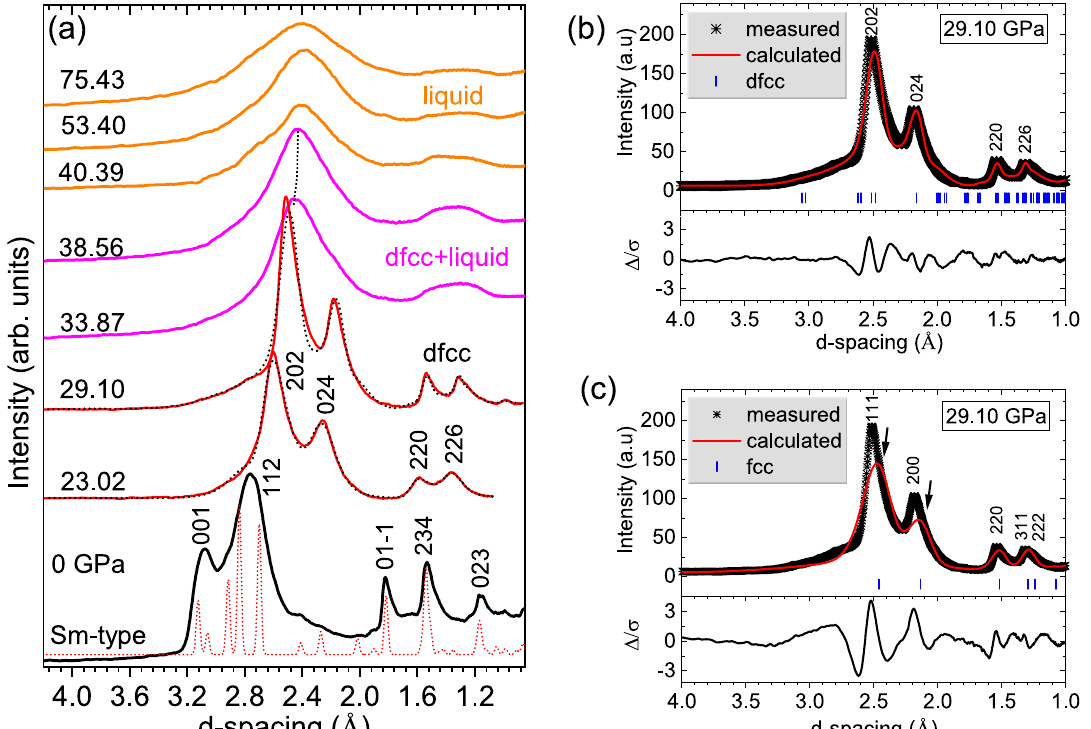
Figure 2. ( a ) Representative x-ray diffraction patterns for different solid, solid+liquid and liquid phases. At 0 GPa, the red dotted line is the simulated x-ray diffraction pattern for Sm-type ambient phase. At 23 and 29 GPa, dotted lines correspond to the Rietveld refined fitting result. ( b ) Rietveld refinement results at 29.1 GPa showing the observed and calculated patterns, reflection tick marks (blue vertical lines) and difference profiles ( �/σ ) shown below the refinement curve) using dfcc, hR24 structure (R-3m) . The structural parameters of a = 6.18 ± 0.05 Å, c = 15.36 ± 0.06 Å, and atomic coordinates of (0, 0, 0.251), and (0.509, -0.509, 0.244) were used for the dfcc phase. ( c ) Rietveld refinement result using the fcc (Fm-3m) phase. The structural parameters of a = 4.47 ± 0.06 Å, and atomic coordinates of (0, 0, 0) were used. The poor fitting results using the fcc structure clearly suggest that dfcc is indeed the stable phase.